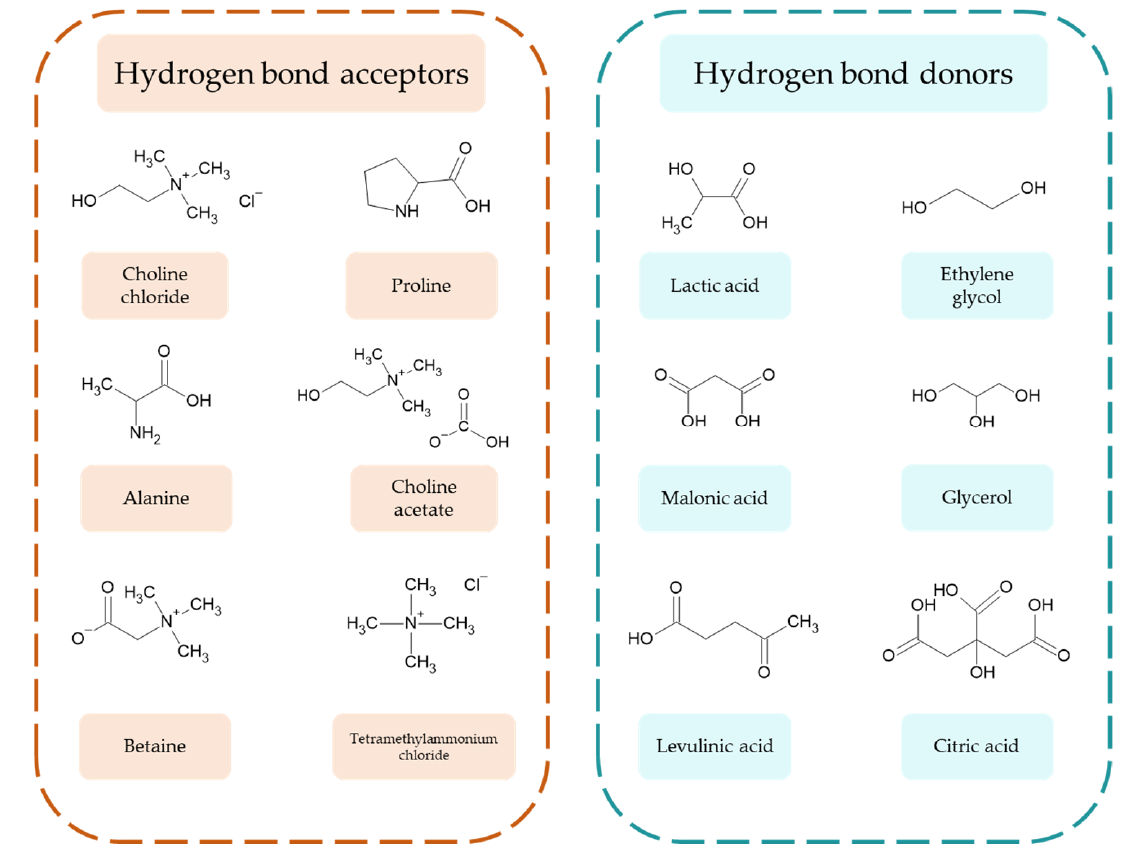
Figure 11. Hydrogen bond acceptors and donors most frequently applied in DESs, used in biomass processing [129–131].